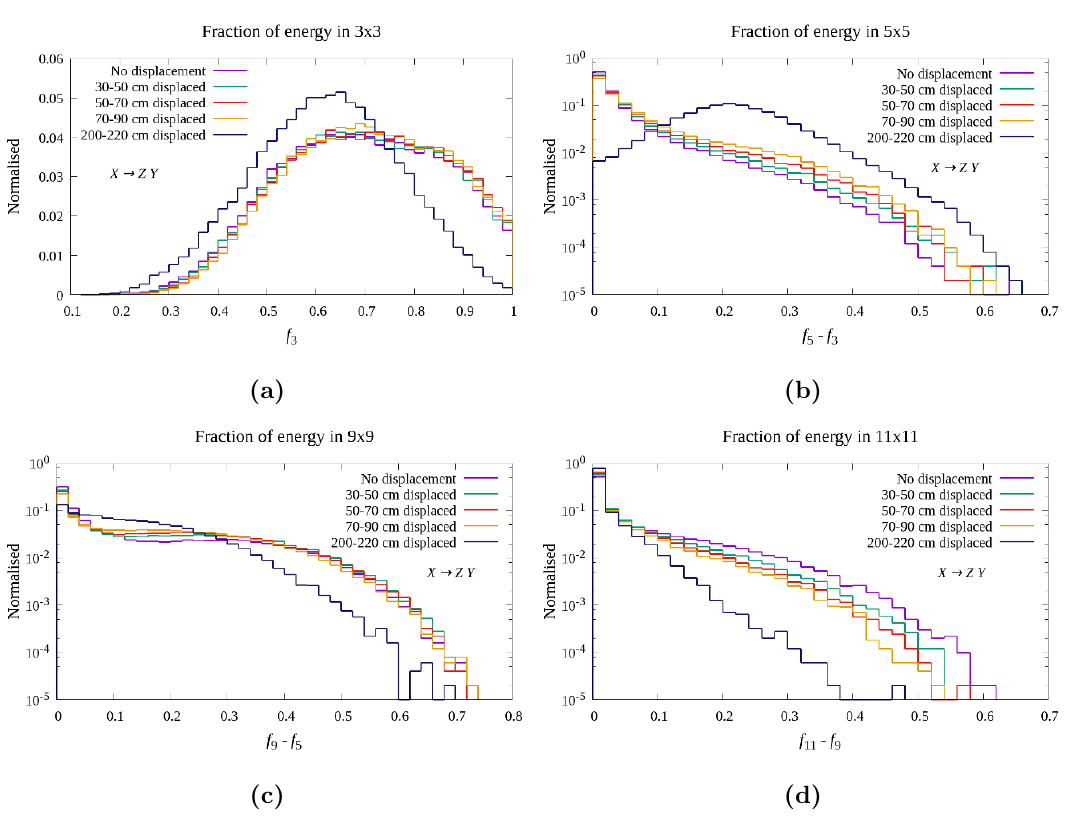
Figure 3. Normalised distributions of energy deposition fraction ( f i ) with varying sizes of blocks ( i (cid:2) i ). (a) Fraction of energy deposited in 3 (cid:2) 3; (b), (c), (d) Fraction of energy deposited in 5 (cid:2) 5, 9 (cid:2) 9 and 11 (cid:2) 11 excluding the previous 3 (cid:2) 3, 5 (cid:2) 5 and 9 (cid:2) 9 blocks’ energy deposition fraction